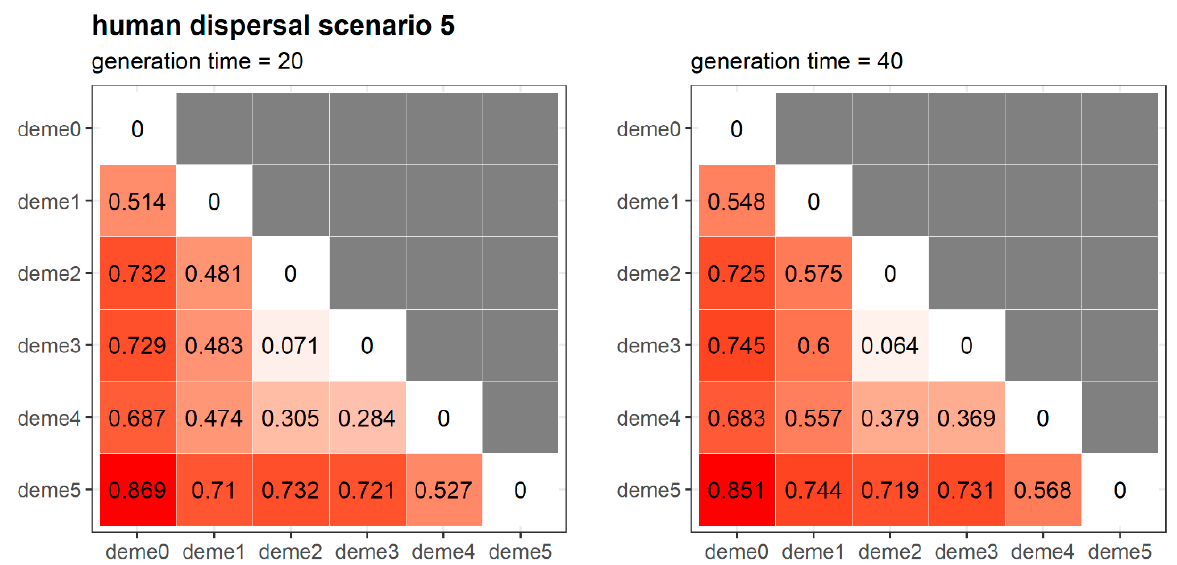
Figure A8. The mean pairwise Fst values calculated across 100 replicate simulations of a post-glacial faunal-mediated dispersal scenario (“hd5” in Table A1). This scenario of Indigenous dispersal assumes an asymmetric stepping-stone model of migration between 5000–200 years ago.